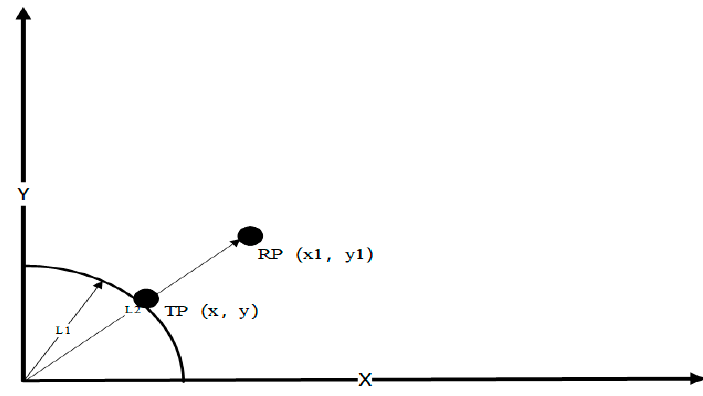
Figure 8. Sensors 2020 , 20 , x FOR PEER REVIEW